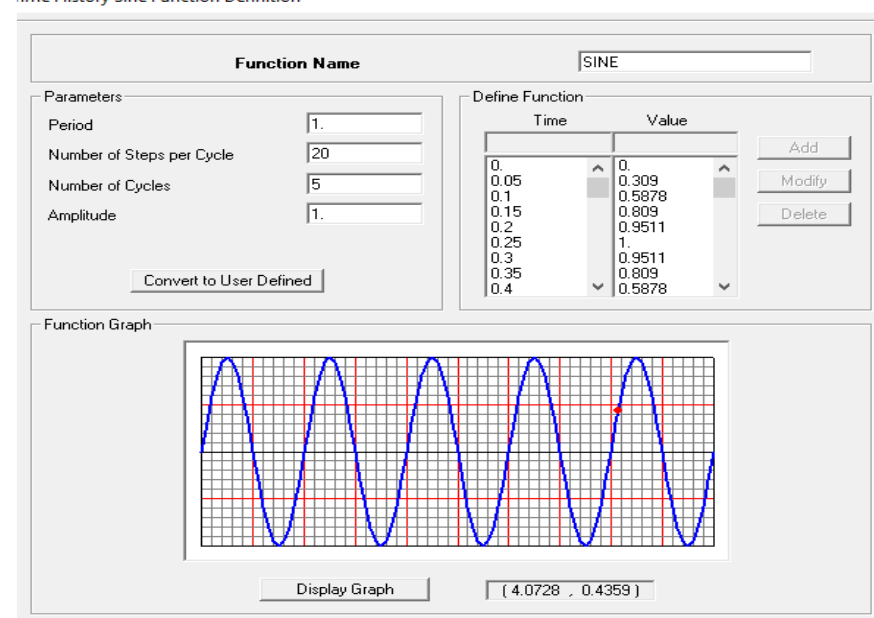
Figure 12. Defined time-history load as sine function.